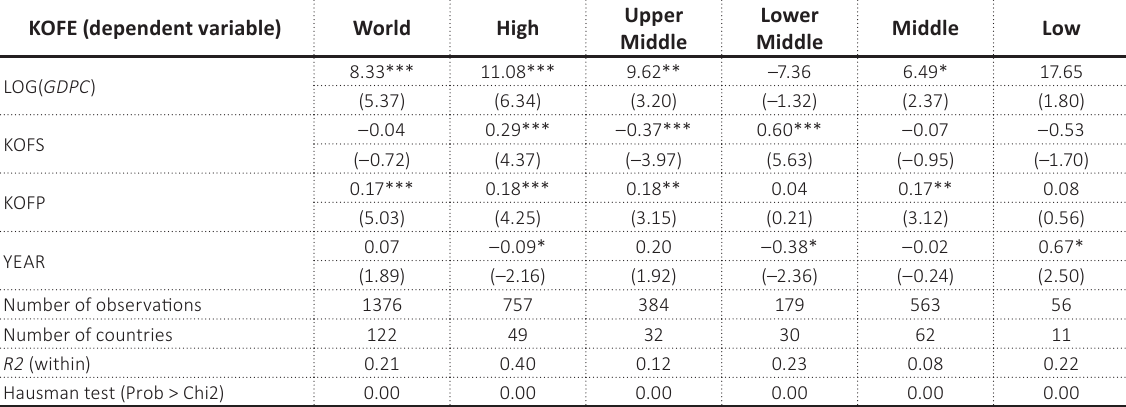
Table 5. GDP and globalization: feedback (1970–2018) KOFE (dependent